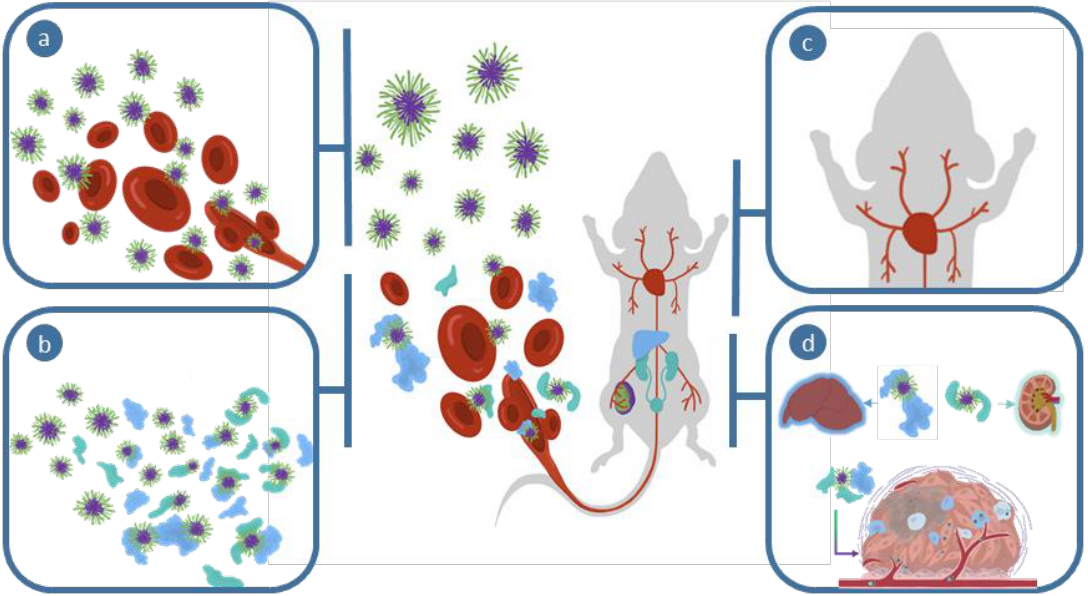
Figure 2. Schematic depicting the interaction between opsonization, biodistribution, and clearance pathways of injected polymer nanomedicines. ( a ) Polymeric materials enter the bloodstream ( b ) become coated with opsonins and other biomolecules during ( c ) systemic transport; a combination of polymer properties and biological interactions lead to ( d ) clearance from the system or accumulation within organs or tumor tissue.